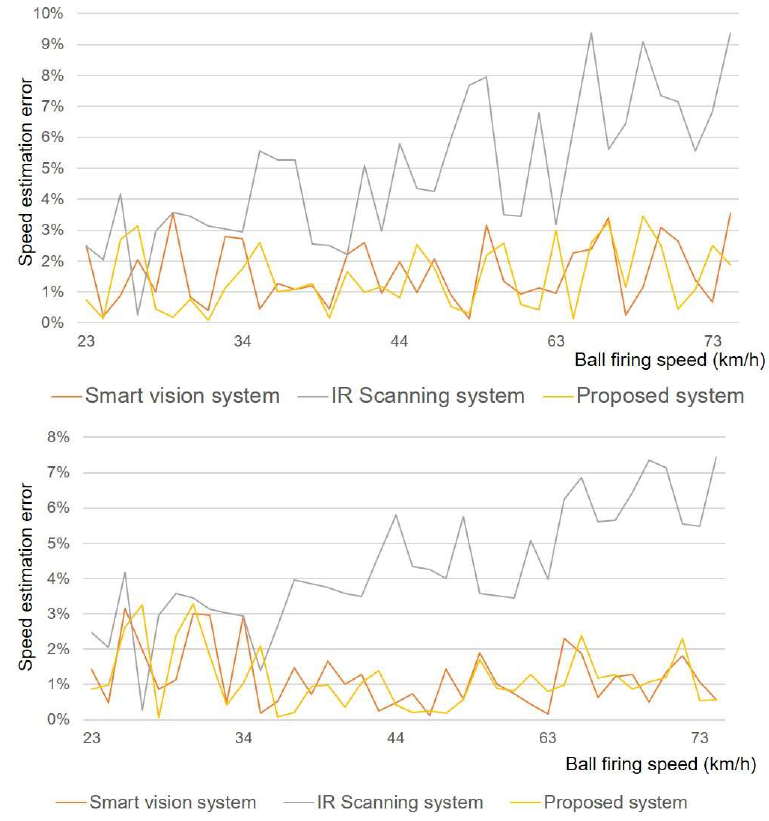
Figure 9. Speed error comparisons of baseball ( top ) and soccer ball ( bottom ) between smart vision system, standalone IR scanning system, and proposed system using Stalker Pro II sports radar gun as reference.